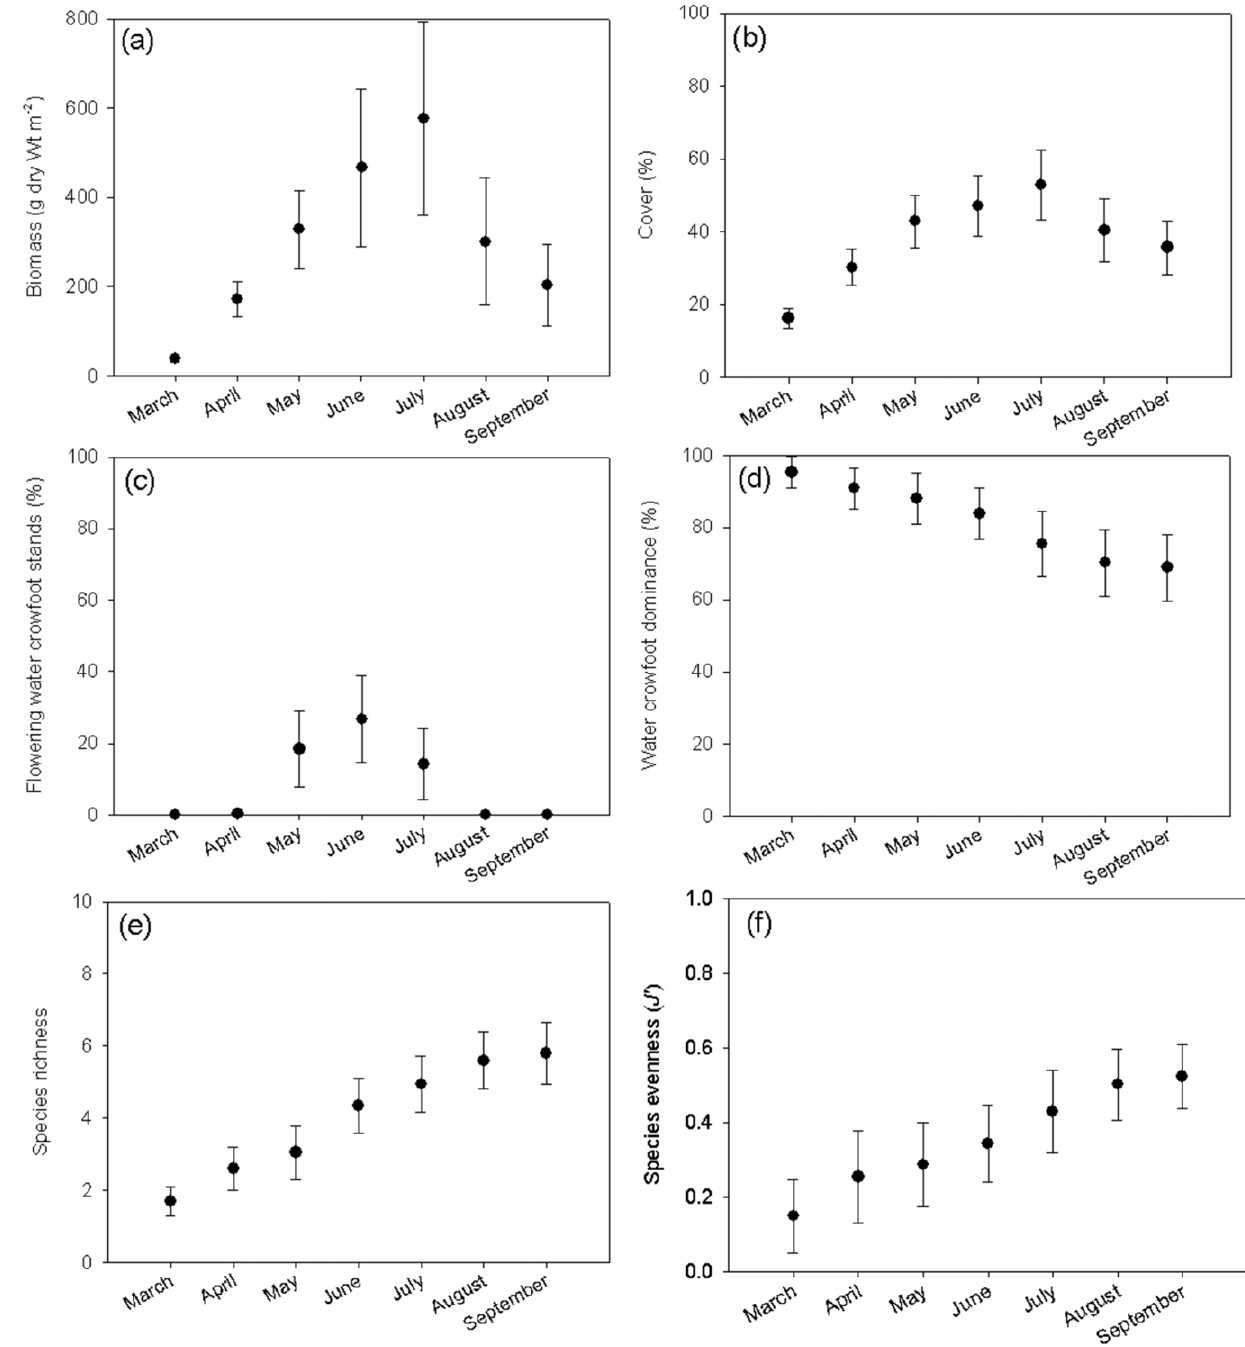
Figure 3. Mean ± 95% CI plant (a) dry weight biomass, (b) cover, (c) R.pseudofluitans dominance, (d) species richness, and (e) species evenness.